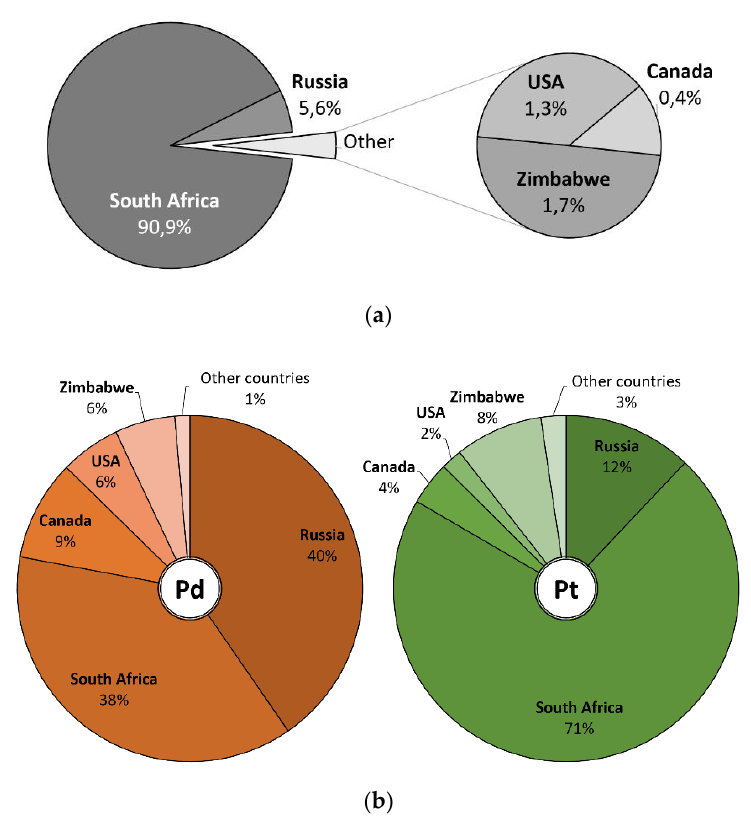
Figure 2. Global management of PGEs (indicating relative percentage) [52,53]: ( a ) Amount of global PGEs reserves in 2019; ( b ) Production of Pd and Pt in 2019.